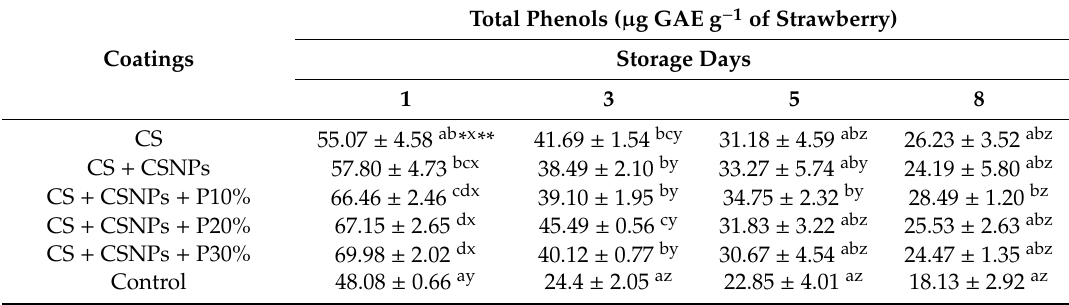
Table 4. Total phenol content of strawberry fruit treated with nanostructured chitosan and propolis coatings during eight days of storage.